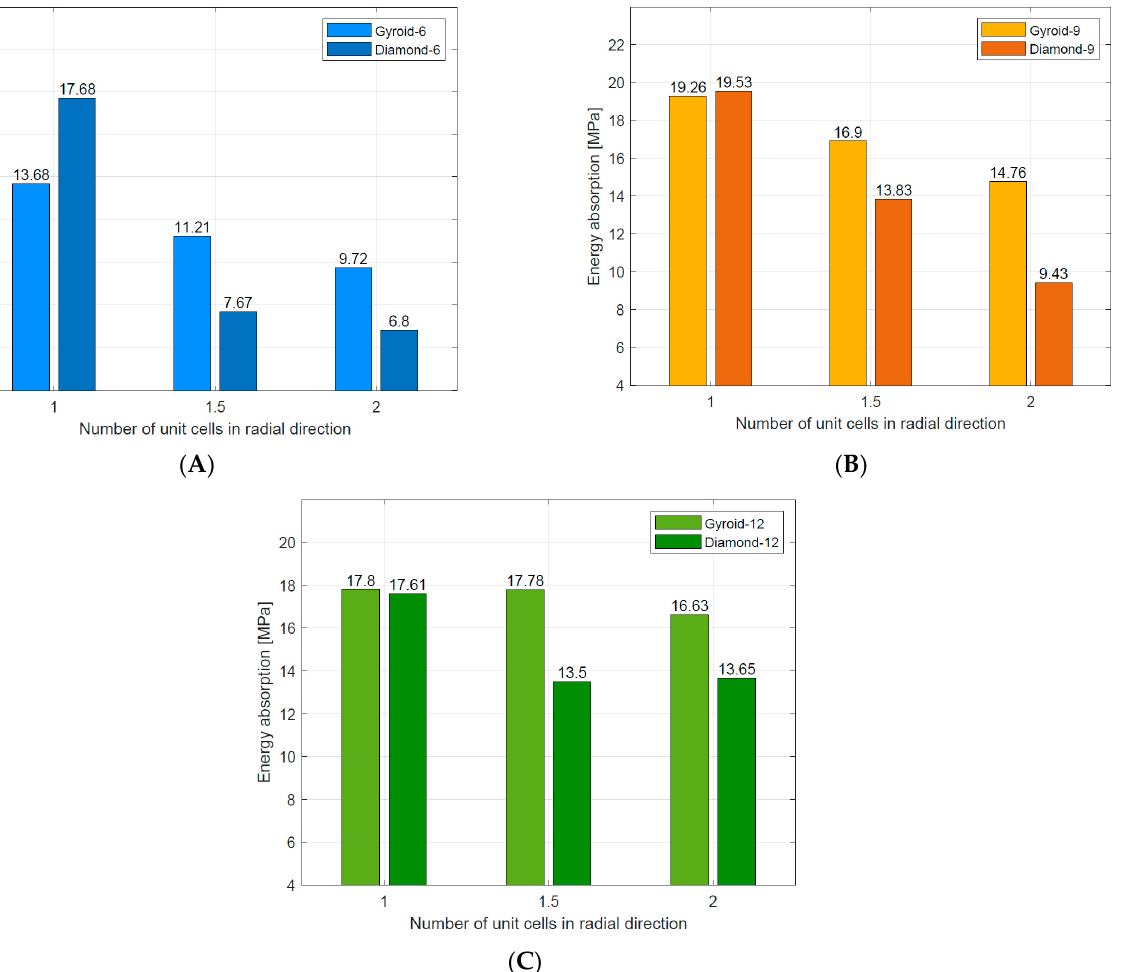
Figure 17. Comparison of energy absorption for Gyroid [49] and Diamond TPMS cylindrical struc- tures with ( A ) n circum = 6; ( B ) n circum = 9; ( C ) n circum = 12.